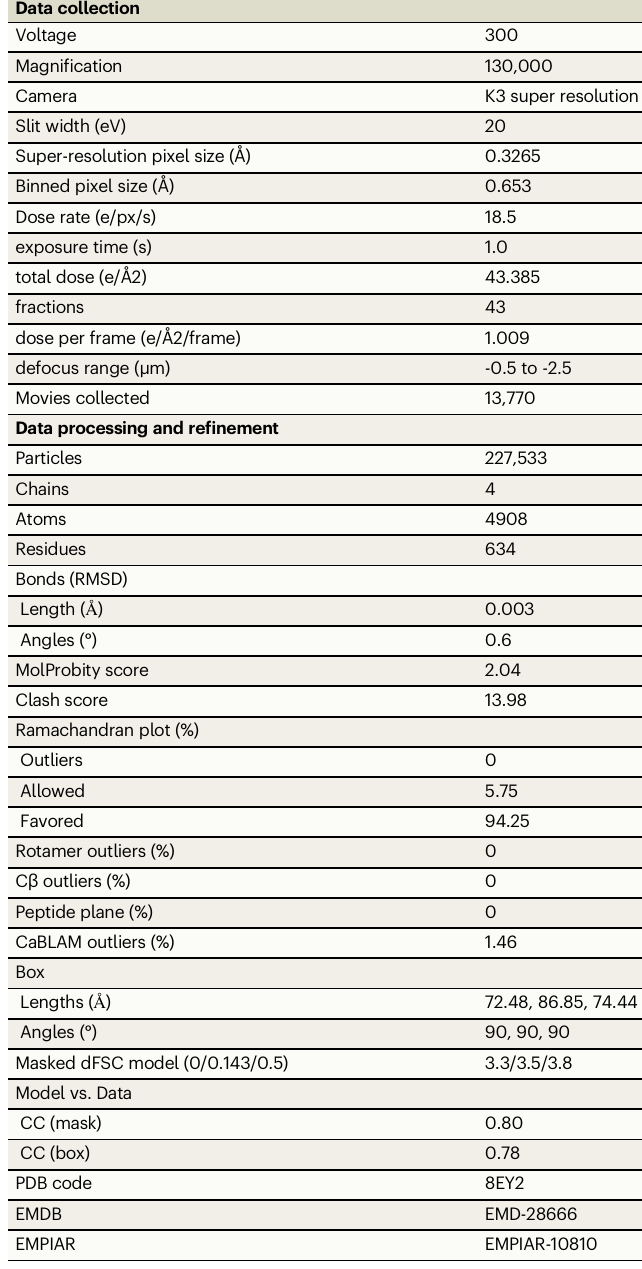
Table 1 | Cryo-EM data collection, re fi nement and validation parameters and